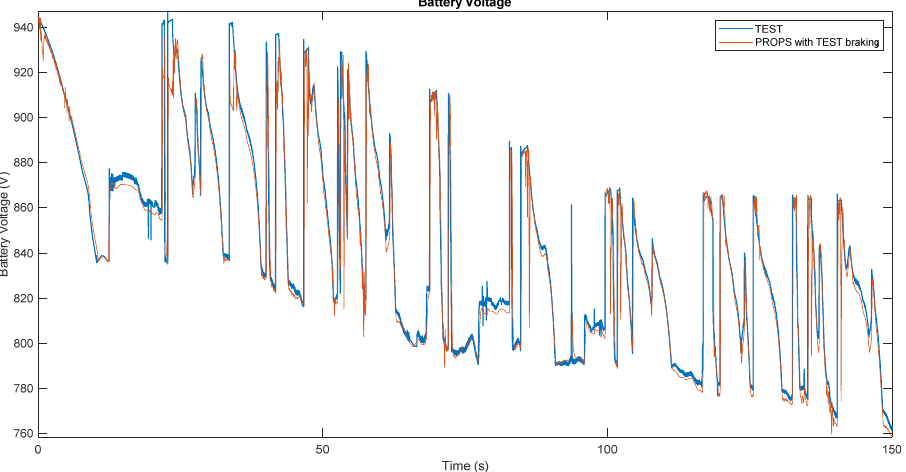
Figure 25. TEST (in blue) and PROPS (in red) battery voltage (in Volt) vs. Lap Time (in seconds). To obtain the performance indices of the TEST model (shown in Table 8), the error was obtained (calculated as the difference between the output parameter of the TEST model and the output parameter of the PROPS model, which has been validated with real- world data [8]) and its mean and standard deviation were calculated. The mean and the standard deviation (std) were also calculated for the absolute value (abs) of the error. It is worth highlighting that both tools have on average the same accuracy and esti- mation capabilities as shown in Table 8; however, the proposed method requires a lower computational burden as it is designed using the “Backwards-Facing” technique as men- tioned in Section 1, which has been proved to be more efficient. This makes this simulation tool suitable for real time applications such as driving simulators [20–23]. The same ap- plies if compared with [13,15]. Furthermore, it is key to note that sampling time 𝑡 (cid:3046) plays an important role on sim- ulation performance, so that a sensitivity analysis has been carried out to assess its influ- ence. In fact, when 𝑡 (cid:3046) is too big the computation is faster but the final accuracy is poor due to aliasing effect, especially when 𝑡 (cid:3046) is lower or close to the sampling rate of the input target speed profile. On the other hand, when 𝑡 (cid:3046) is too small the computational burden